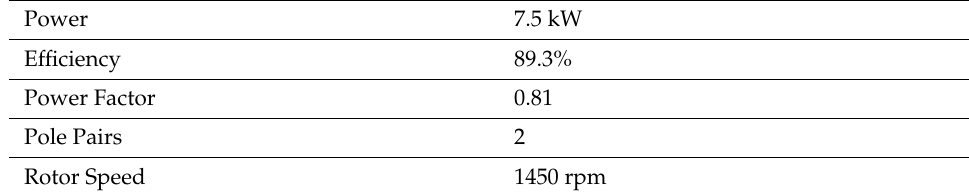
Table A4. Induction motor